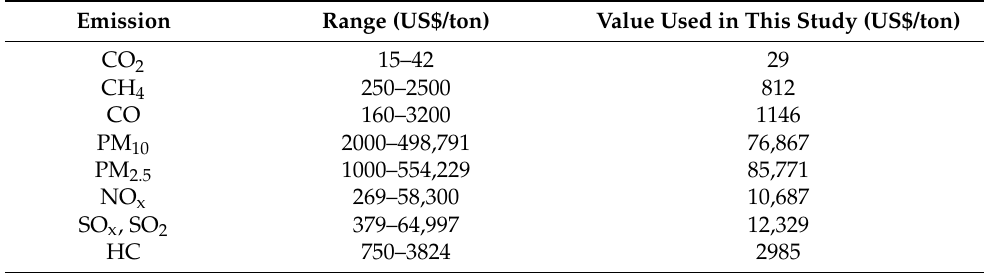
Table A2. Social cost factors (SCF).